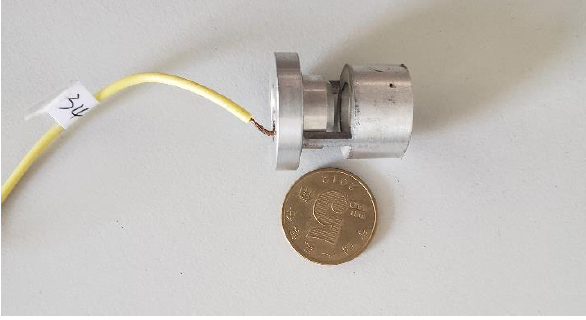
Figure 5. Blowing experimental test system.